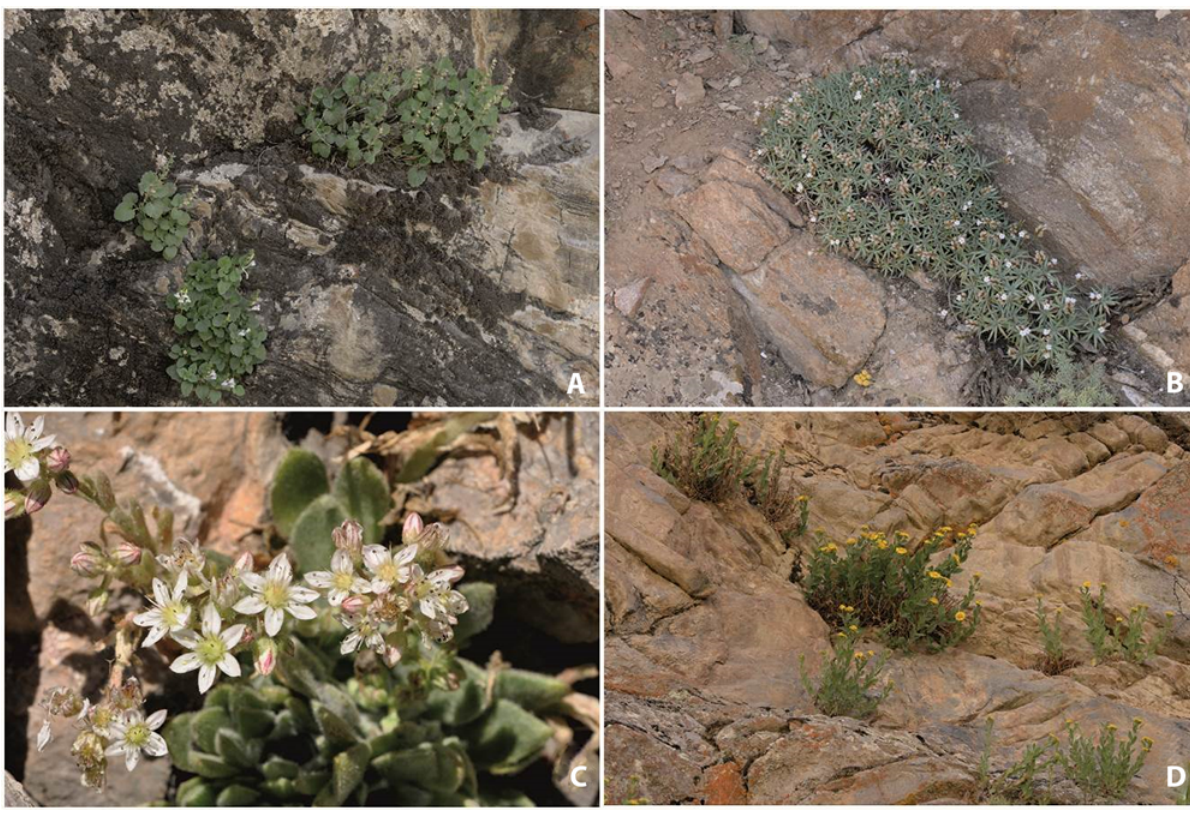
Figure 6 Photographs of the chasmophytic vegetation belonging to the: ( A ) Scutellarietum schugnanicae on the limestone rocks in the Panj River Valley neat Qualaikhum, ( B ) Acantholimonetum alexeenkoani on the limestone rock cles near Ishkashim in the Southern Pamir, ( C ) community of Rosularia alpestris on the limestone ledges in the Alai Range near Osh, ( D ) Inuletum schmalhausenii on the limestone rock cles in the Ghunt River Valley close to Khorogh. All pictures were taken by A.